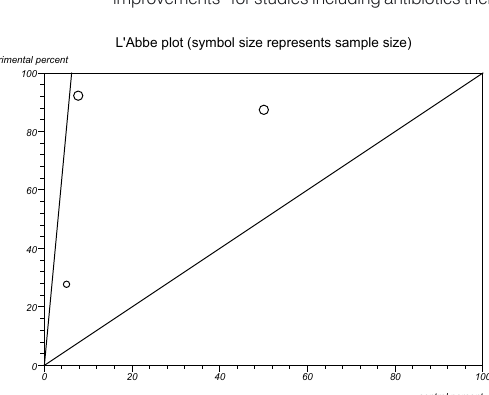
Figure 3. Heterogeneity indicators for the outcome of “clinical improvements” for studies including antibiotics